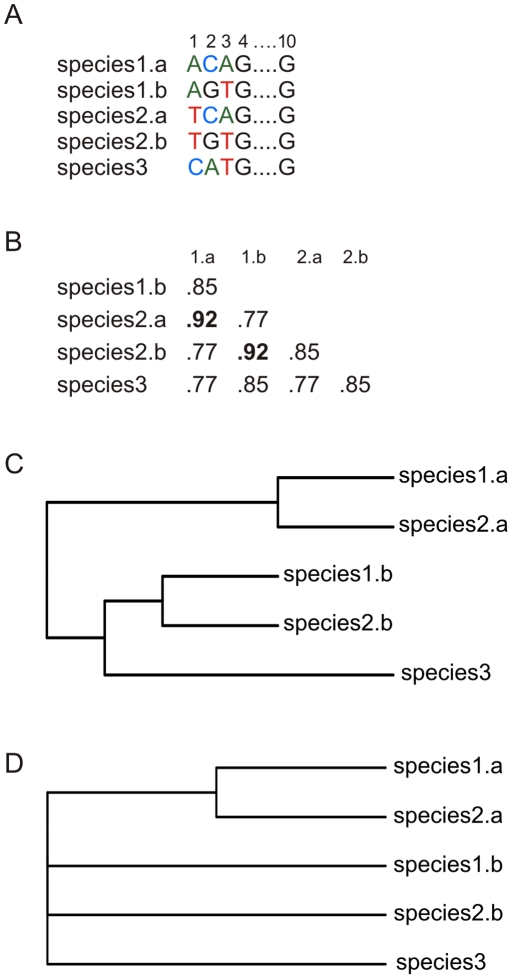
Hypothetical DNA barcode sequences where tree-based and similarity methods produce incorrect identifications.A. Alignment where two recently diverged sister species (species1 and species2) have only one diagnostic nucleotide differentiating them from each other (position 1) and at the same time share two polymorphisms (positions 2 and 3). Species3 is included as outgroup; B. Pairwise uncorrected similarities based on the alignment with highest pairwise similarities in boldface; C. Neighbor joining tree; D. Strict consensus of all maximum parsimony trees.